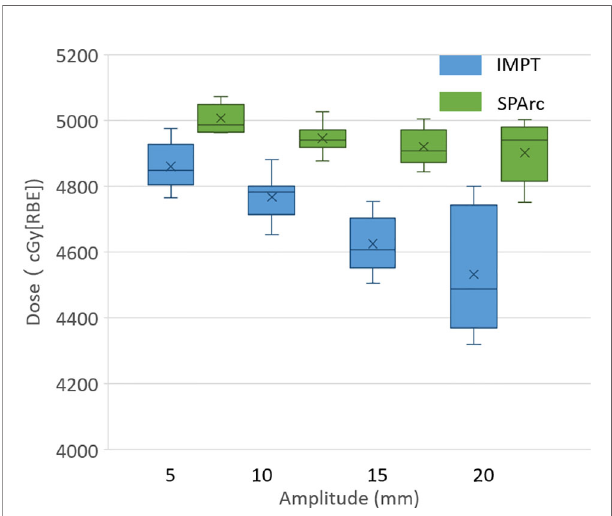
FIGURE 1 | Single fraction dynamic dose for target D99 along with different motion amplitude from 5 to 20